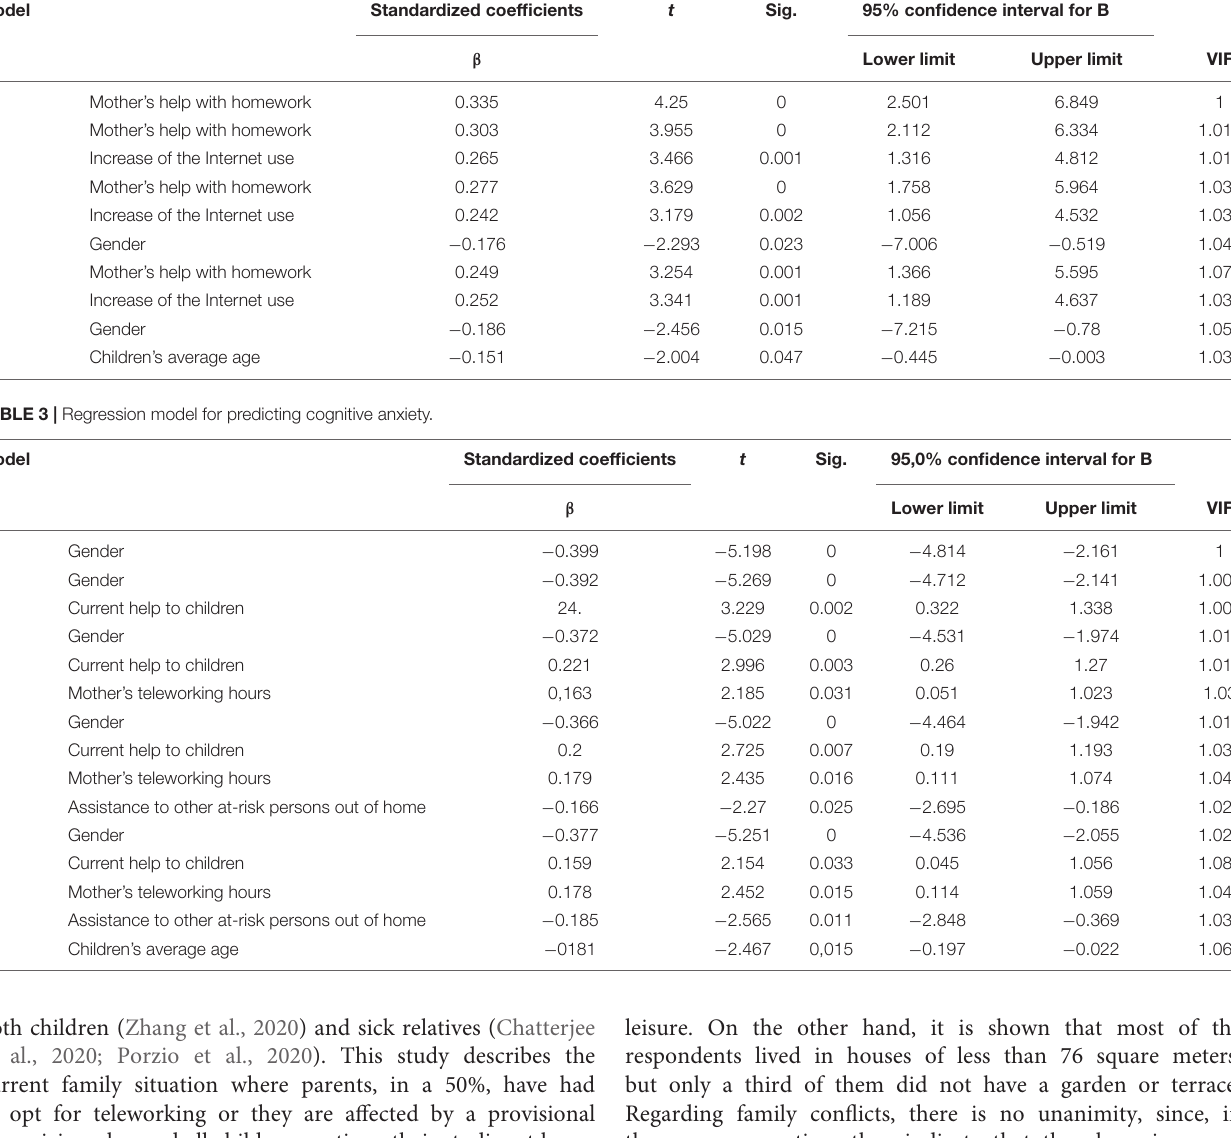
TABLE 2 | Regression model for predicting anxiety.